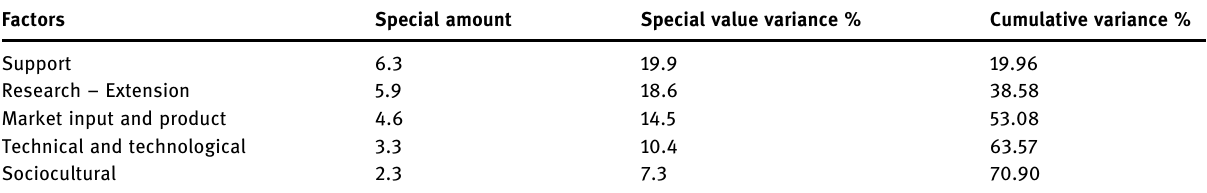
Table 5: Extracted factors with eigenvalue, percentage of variance, and cumulative percentage of their cumulative variance Factors